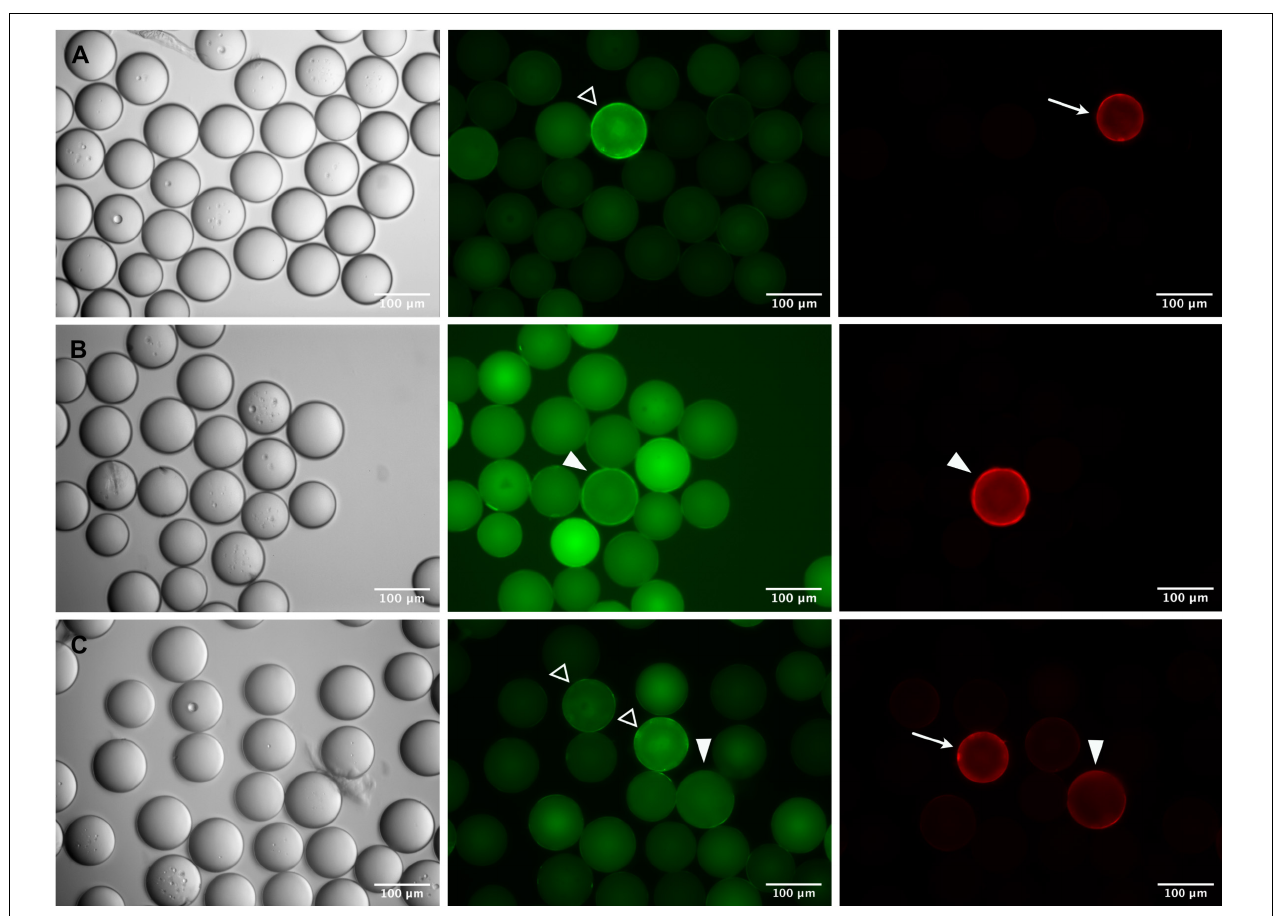
FIGURE 5 | Identification of specific epitope-carrying beads in a pre-adsorbed OBOC library. Specific c-myc- (A,B) or Ara h 2- (C) beads were mixed 1:1,000 with an OBOC library. Beads were incubated with a FITC-labeled monoclonal anti-IgE antibody to block cross-reactive sequences and subsequently screened with anti-c-myc IgE (A,B) or serum from a peanut-allergic patient (C) followed by detection of IgE-binding with a phycoerythrin-labeled monoclonal anti-IgE antibody. Phase contrast images are shown on the left, corresponding fluorescence images of the green and the red channel are in the middle and on the right side of the panel. “True positive” beads carrying the specific epitope sequence are recognizable by strong fluorescence only in the red channel (arrows) and only slight autofluorescence in the green channel; pre-adsorbed “cross-reactive” beads show a strong fluorescence with corona in the green channel (open arrowheads), and no signal in the red channel. A number of fluorescent beads cannot be clearly assigned to either “positive” or “cross-reactive,” exhibiting similar fluorescence intensities and/or coronas in both, the red and the green channel (closed